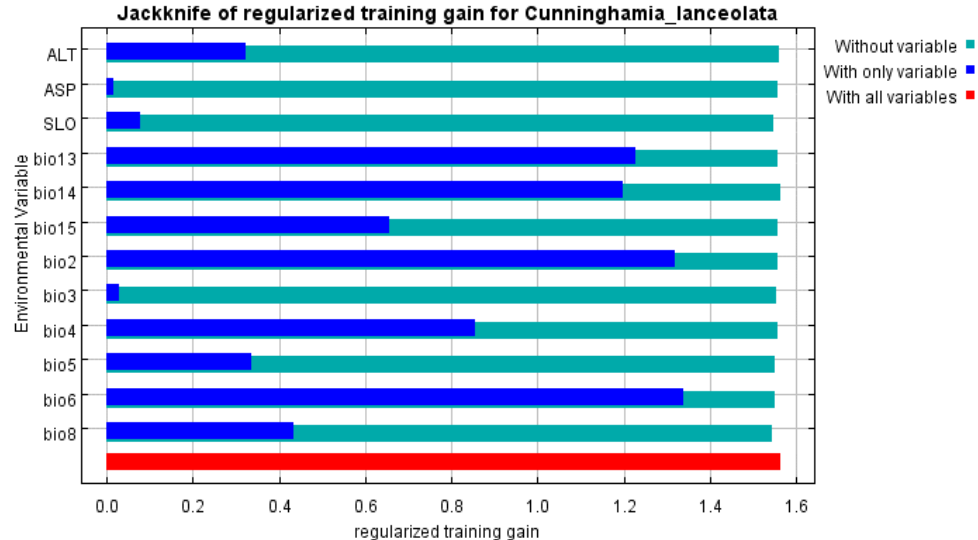
Figure 3. Jacknife test of variable importance for C. lanceolata.